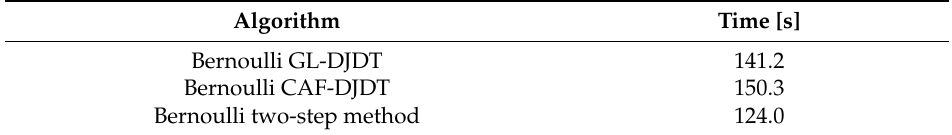
Table 1. Execution time per